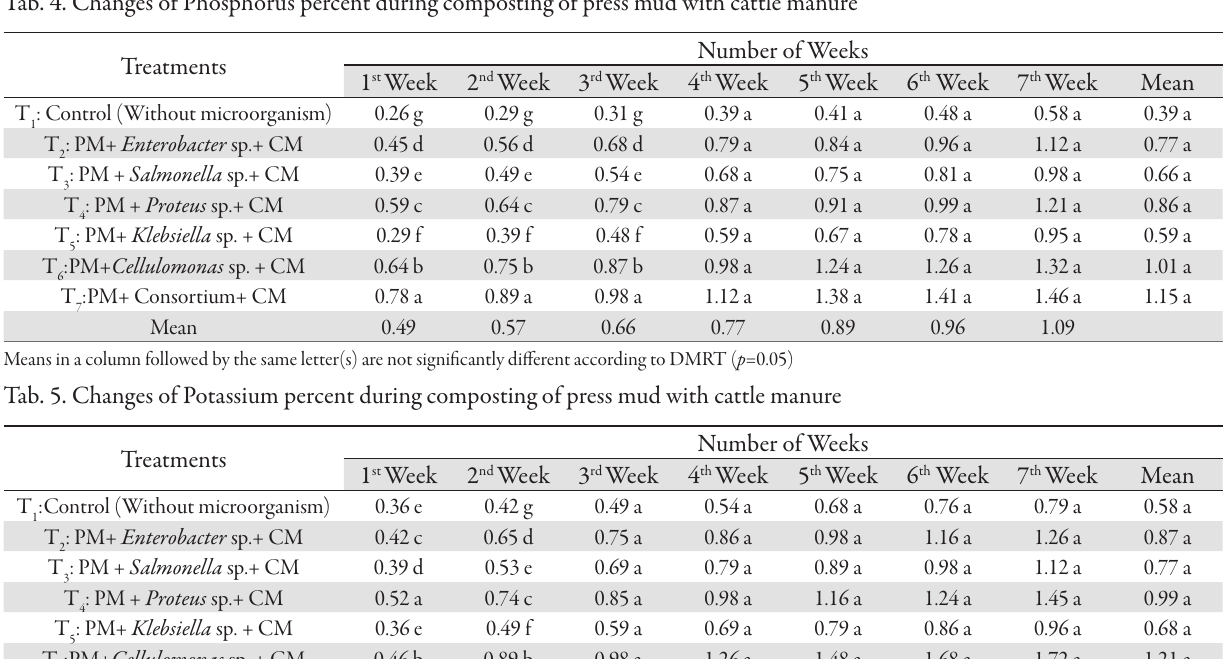
Tab. 4. Changes of Phosphorus percent during composting of press mud with cattle manure Treatments